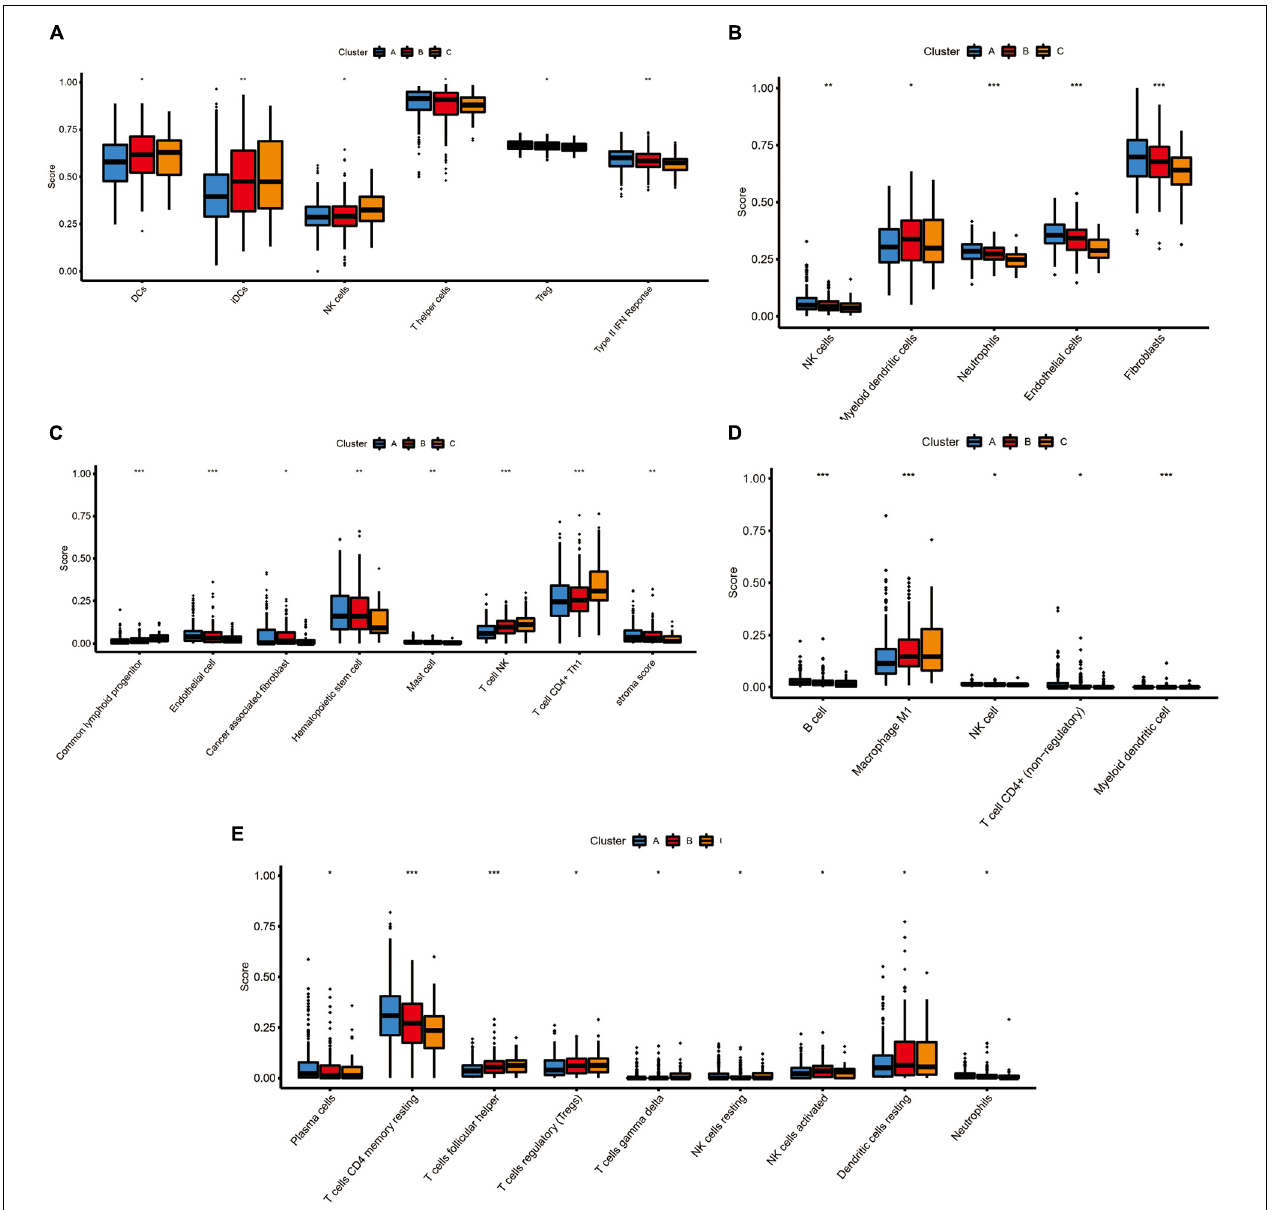
FIGURE 5 | The immune landscape of three pyroptosis-related molecular subtypes. (A) The results of single-sample gene set enrichment analysis (ssGSEA): boxplots of ssGSEA scores among three molecular subtypes. (B) The results of MCPcounter analysis: boxplots comparing the abundances of immune cell subsets among three molecular subtypes. (C) The results of xCell analysis: boxplots comparing the abundances of immune cell subsets among three molecular subtypes. (D) The results of quanTIseq analysis: boxplots comparing the abundances of immune cell subsets among three molecular subtypes. (E) The results of CIBERSORTx analysis: boxplots comparing the abundances of immune cell subsets among three molecular subtypes. Adjusted P -values were showed as: ns, not significant; * P < 0.05; ** P < 0.01; *** P <